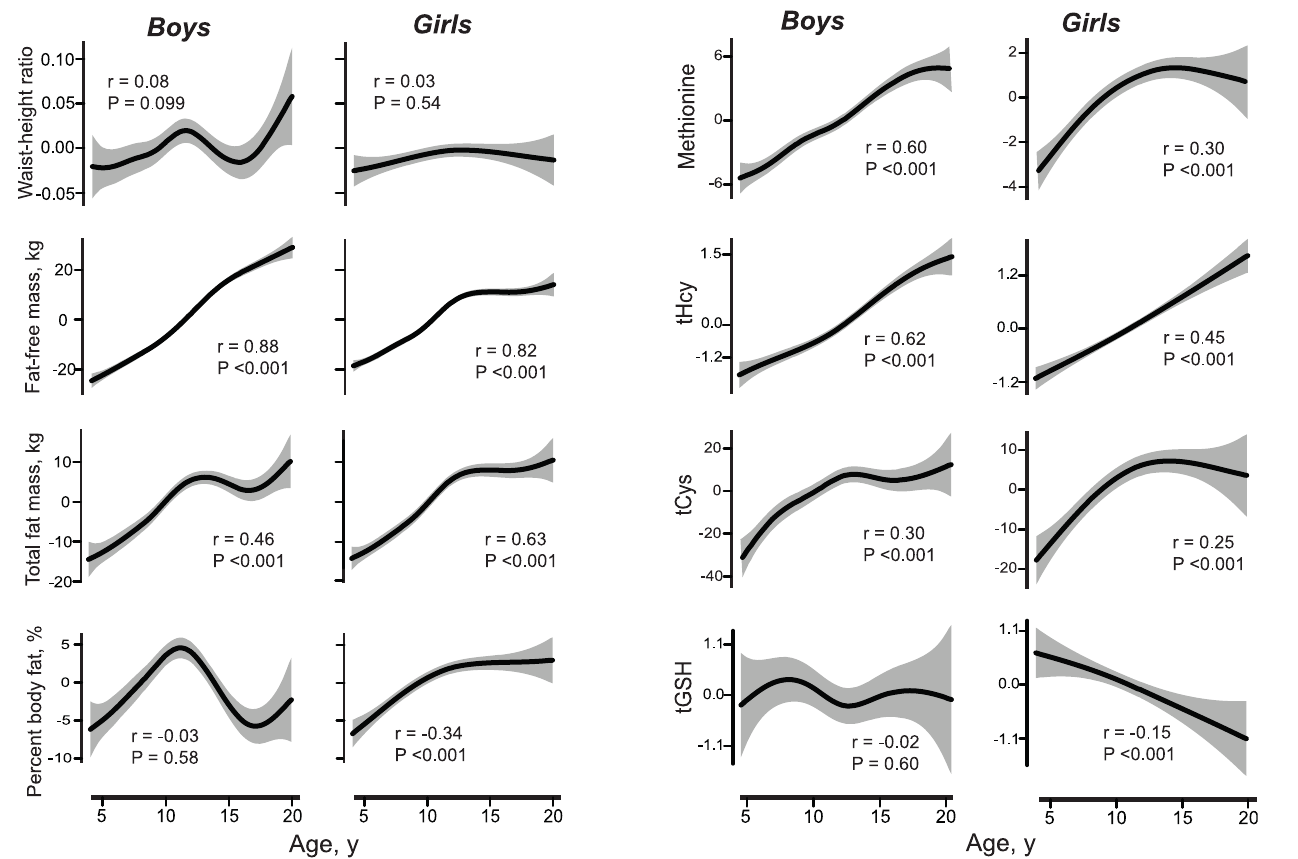
Figure 1. Age, body composition and sulfur amino acids. Dose-response curves (solid lines) with 95% confidence intervals (shaded area) for the association of age with body composition parameters (A) and with plasma concentrations ( m mol/L) of methionine, tHcy (total homocysteine), tCys (total cysteine) and tGSH (total glutathione). Figures were constructed using generalized additive regression models in R (see Methods section for details). At approximately mean exposure of the independent variable, the model generates a reference value of zero for the dependent variable. P -values and correlation coefficients were obtained from corresponding Pearson correlation analysis. doi:10.1371/journal.pone.0044166.g001 Figure-3-B). After controlling for body fat%, high tCys remained associated with a 2-fold risk of insulin resistance.